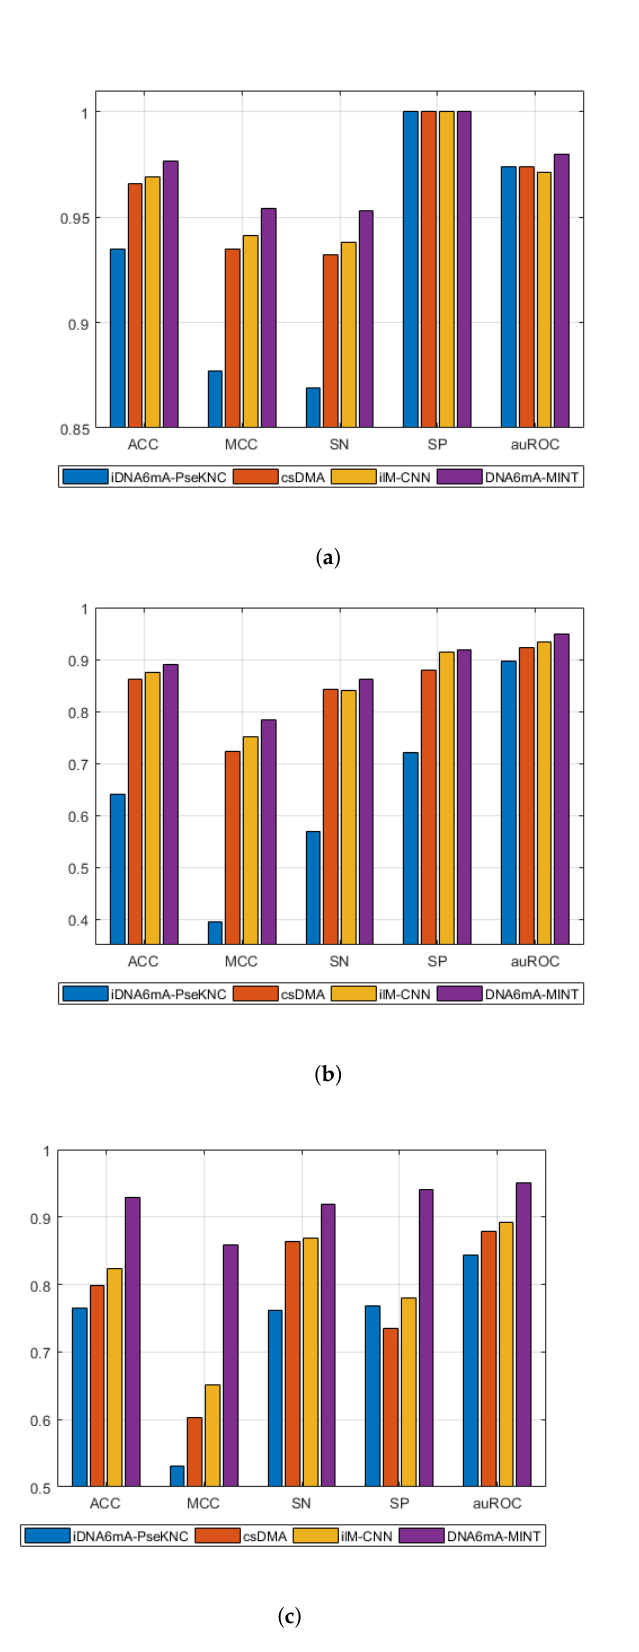
Figure 2. Graphical comparison of DNA6mA-MINT with state-of-the-art tools using five fold cross validation on different species. ( a ) Mus musculus , ( b ) Rice, ( c ) “Combined-species”. Acronyms are Sensitivity (SN), Specificity (SP), Accuracy (ACC), Matthews Correlation Coefficient (MCC), and area under the Receiver Operating Characteristics